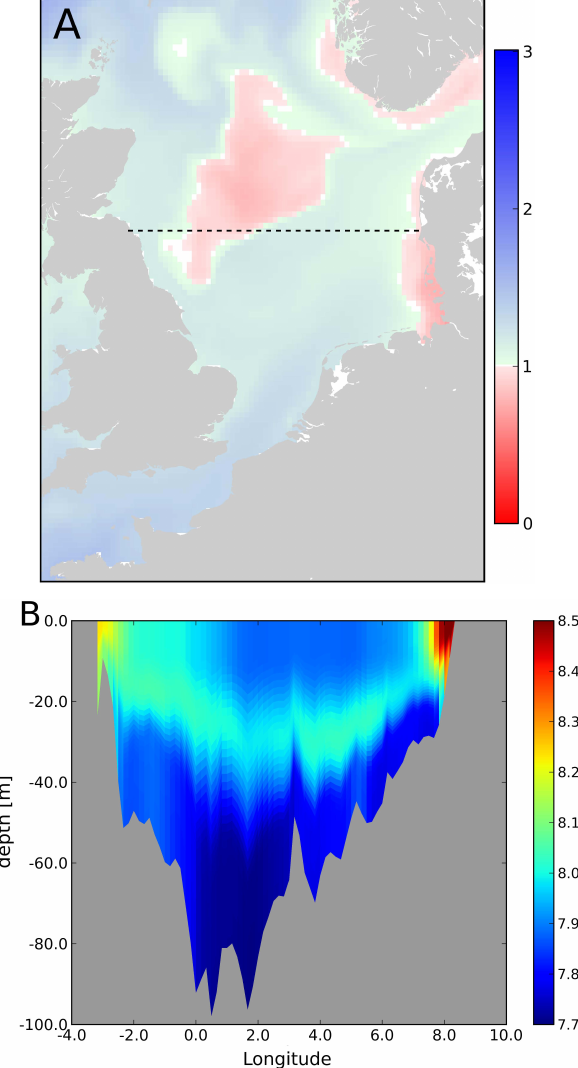
Fig. 3. Importance of the vertical variability of the carbonate sys- tem. (a) Mean values over the 20yr simulation period of the annual minimum of saturation state of aragonite in the bottom waters in the A1B scenario. Red areas highlight undersaturation. Dashed black line indicates the location of the transect shown in the right figure. (b) Mean summer pH on a W–E transect along 56 ◦ N in the A1B